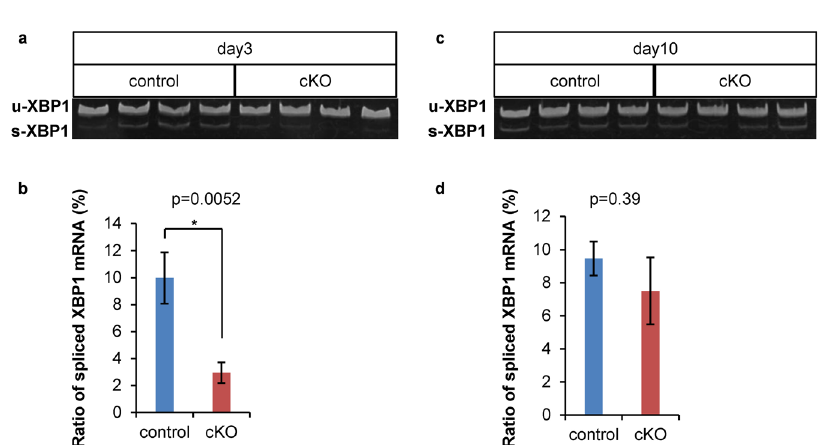
Figure 5. Splicing of Xbp1 mRNA was suppressed in Ptf1a cKO mice on day 3 but recovered by day 10. ( a ) Representative electrophoresis of RT-PCR products of unspliced and spliced Xbp1 mRNA on day 3. ( b ) Comparison of the percentage of spliced Xbp1 mRNA on day 3 in control and Ptf1a cKO mice. control, n = 5; Ptf1a cKO, n = 6. ( c ) Representative electrophoresis of RT-PCR products of unspliced and spliced Xbp1 mRNA on day 10. ( d ) Comparison of the percentage of spliced Xbp1 mRNA on day 10 in control and Ptf1a cKO mice. control, n = 6; Ptf1a cKO, n = 5. * P < 0.05. The original, unprocessed scans of the gels are shown in Supplementary Fig.